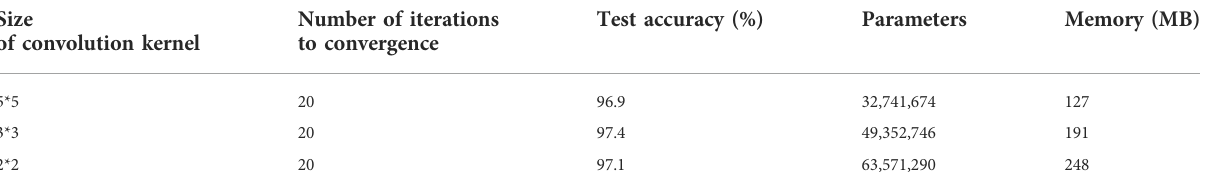
Figure 2C, the diagnostic accuracy of the AlexNet model for abnormal wells is relatively high. According to the diagnosis, error- prone situations that occur include fi xed valve leakage, insuf fi cient